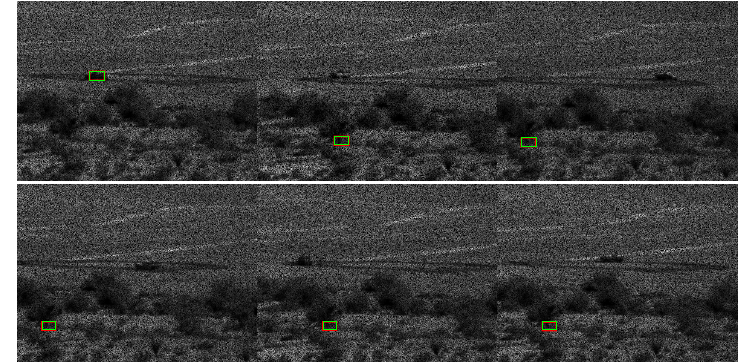
Figure 6. STAPLE tracking results for the PCE full case. Frames: 10, 30, 50, 70, 90, and 110 are shown here.